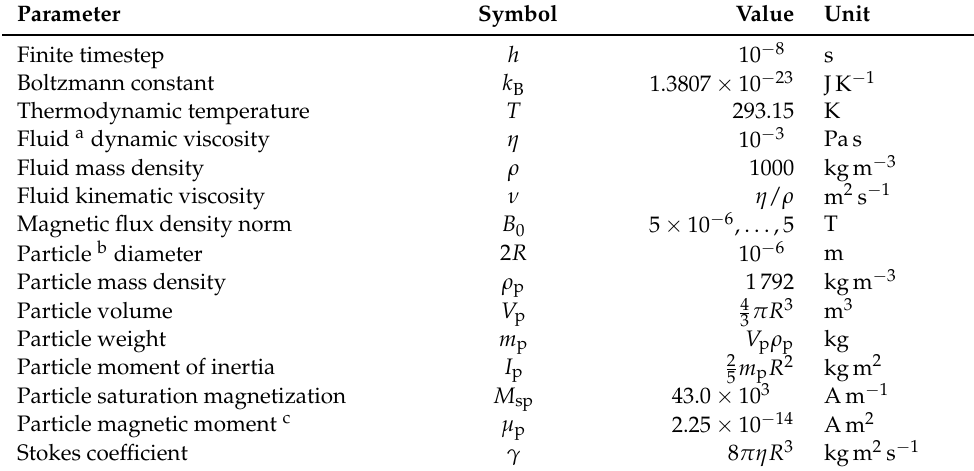
Table 1. Values of parameters used in simulations.